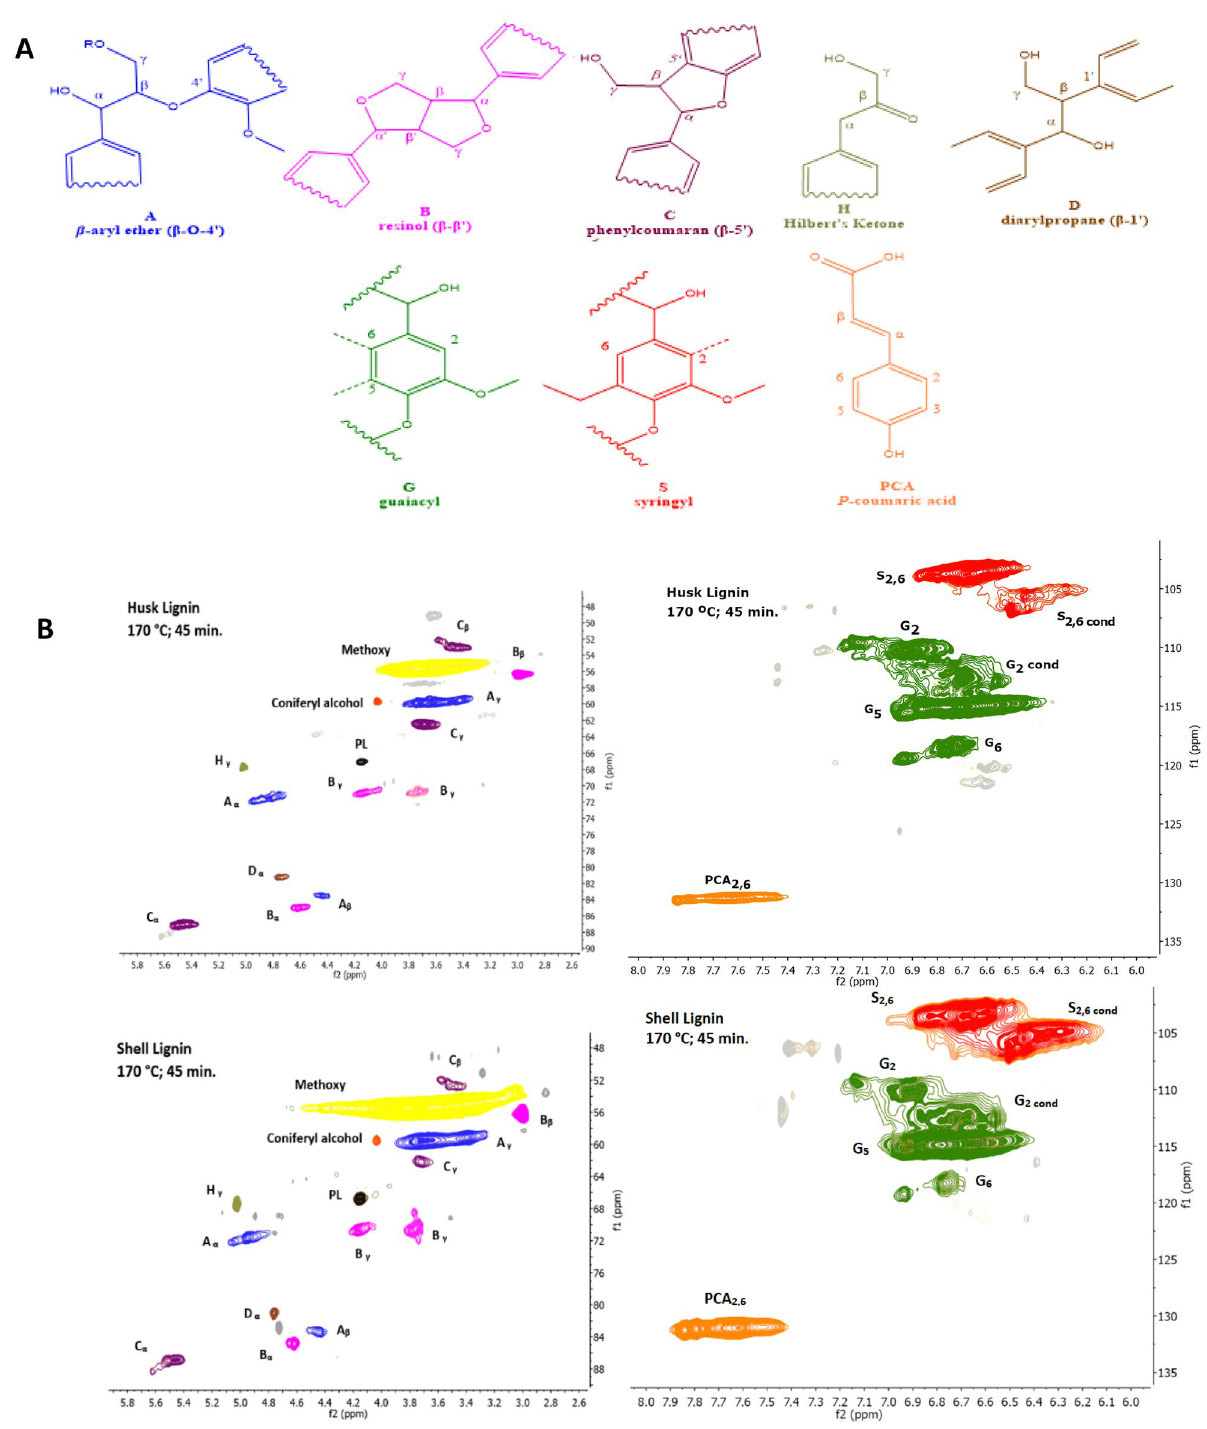
Figure 3. ( A ) Important inter-unit linkages and subunits found in the husk- and shell-lignin, and ( B ) HSQC NMR side-chain (left) and aromatic spectra regions (right) units for lignins isolated from 1:10 g/g biomass (husk and shell) and [DMBA][HSO 4 ] with 20 % water at 170 °C for 45 Lignin structural properties. Lignins isolated at the optimised pretreatment conditions at (170 °C and 45 min) were analysed with HSQC NMR spectroscopy, to establish the lignin subunits and linkages present. Figure 3A shows the important structural subunits and linkages found in husk and shell lignin, while the spectra regions are presented in Fig. 3B and Fig. S1 for additional data. The amounts of husk- and shell-lignin subunits and linkages were estimated from the raw HSQC NMR spectra (Fig. 4) using a semiquantitative technique 28,43 . All signal intensities were normalized to 100% abundance of